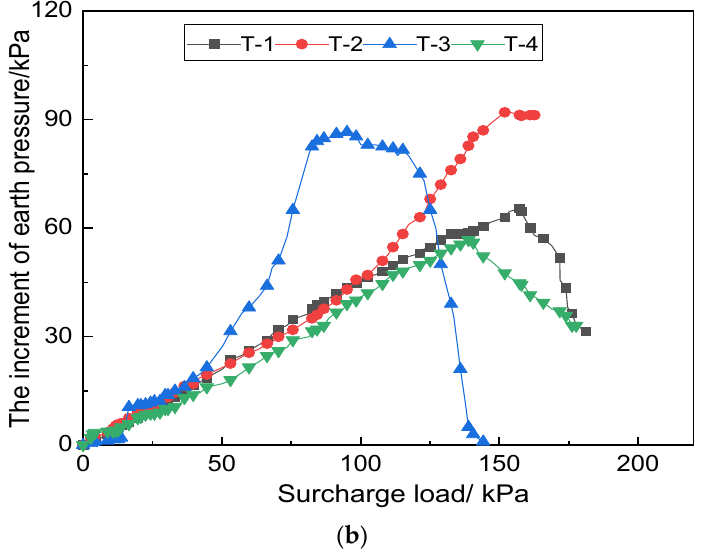
Figure 4. Relationship between the increment of earth pressure and the surcharge load: ( a ) S6; and ( b ) S7.